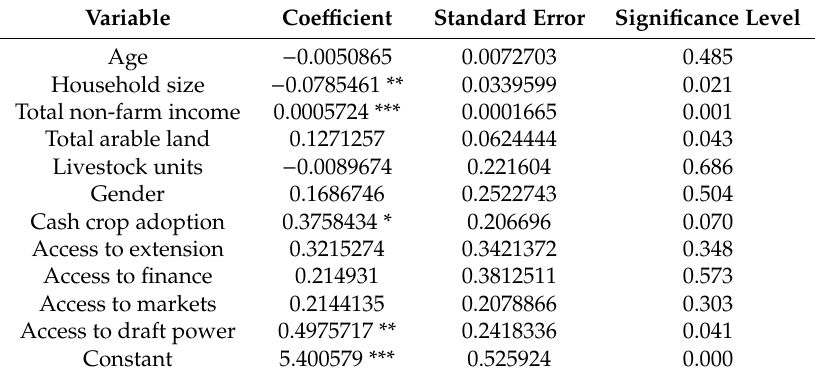
Table 3. Tobit results for factors a ff ecting food security in Shamva District,